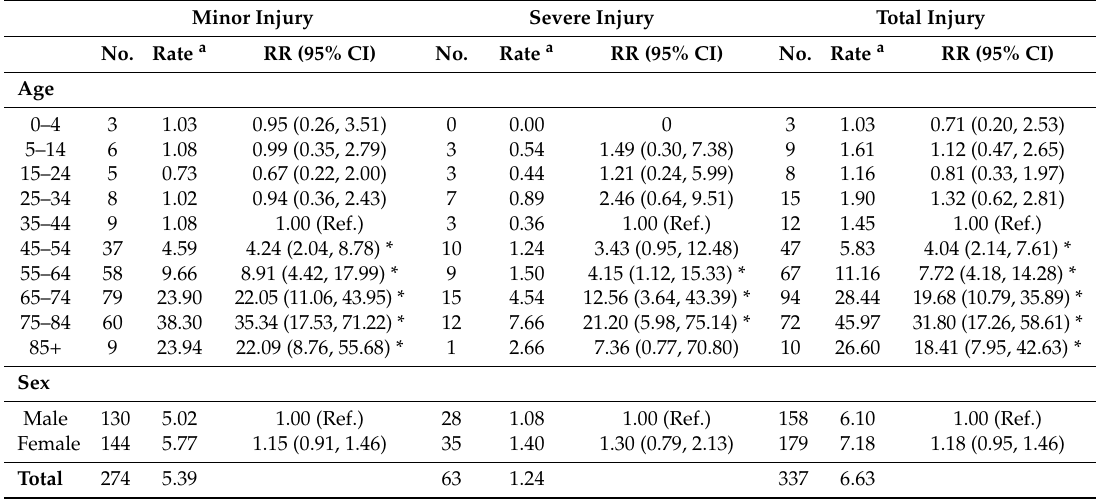
Table 2. Demographics of injuries in the Funing tornado, 23 June